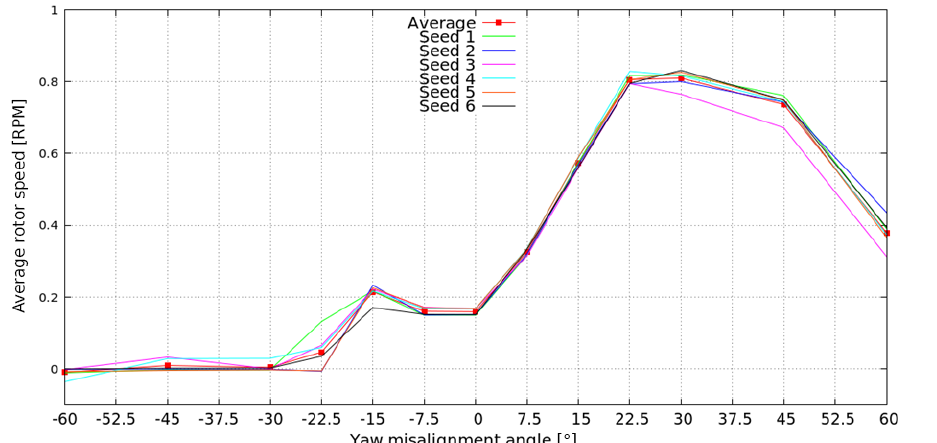
Figure 15. Rotor idling speed versus yaw angle for the pitch angle 87 ◦ . Average rotor speed of six different 10min wind seeds and their average.